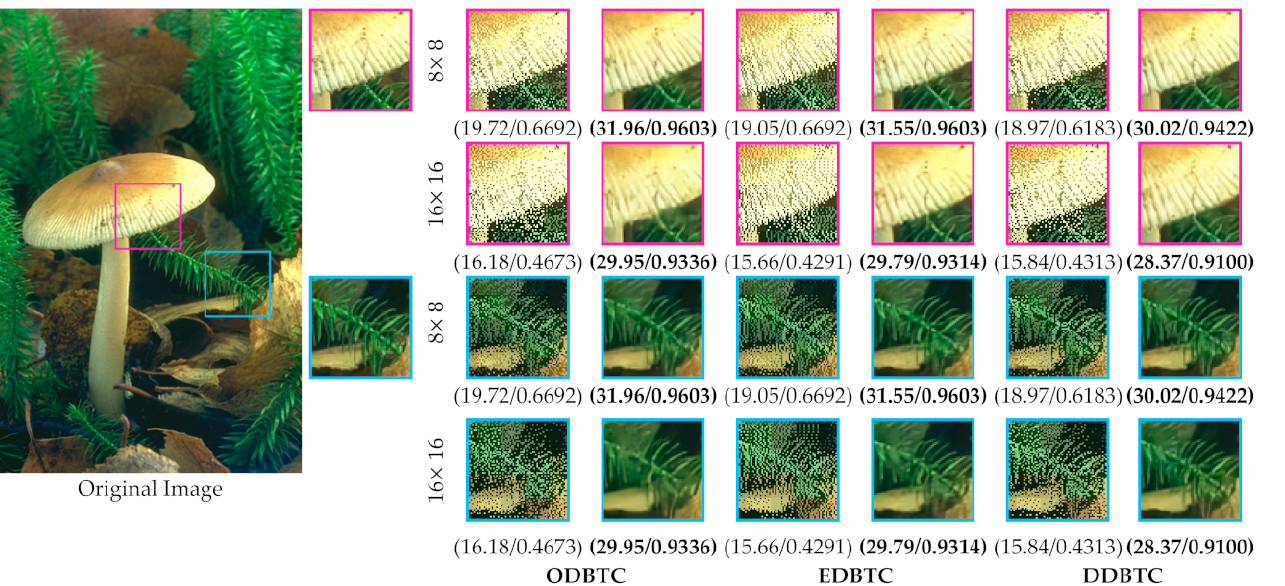
Figure 13. Performance comparisons over various H-BTC methods on an image 208001 from the BSD100